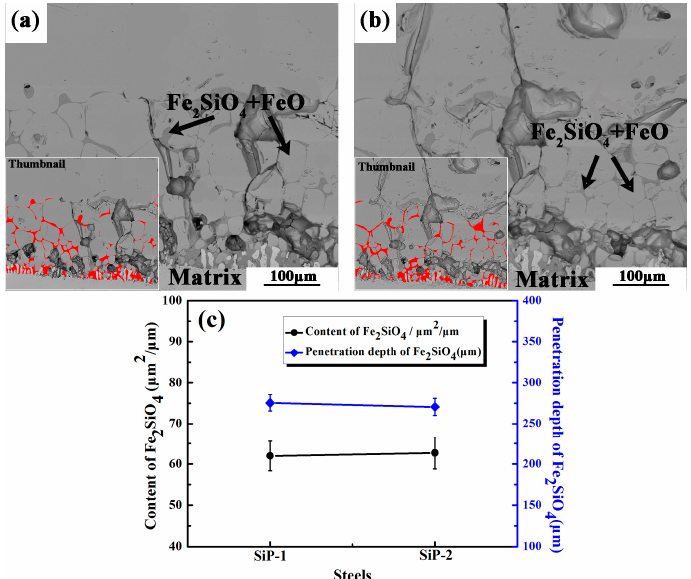
Figure 2. SEM images of the oxide scale obtained with the backscattered electron (BSE) detector. ( a ) SiP ‐ 1; ( b ) SiP ‐ 2; ( c ) The contents and penetration depths of Fe 2 SiO 4 in the two specimens.